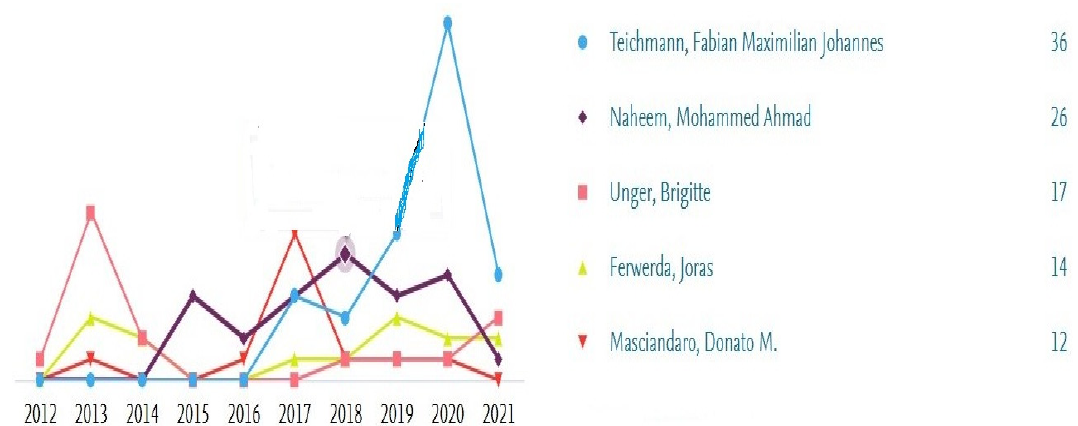
Figure 3. Top five author’s scholarly output, 2012 to 2021.